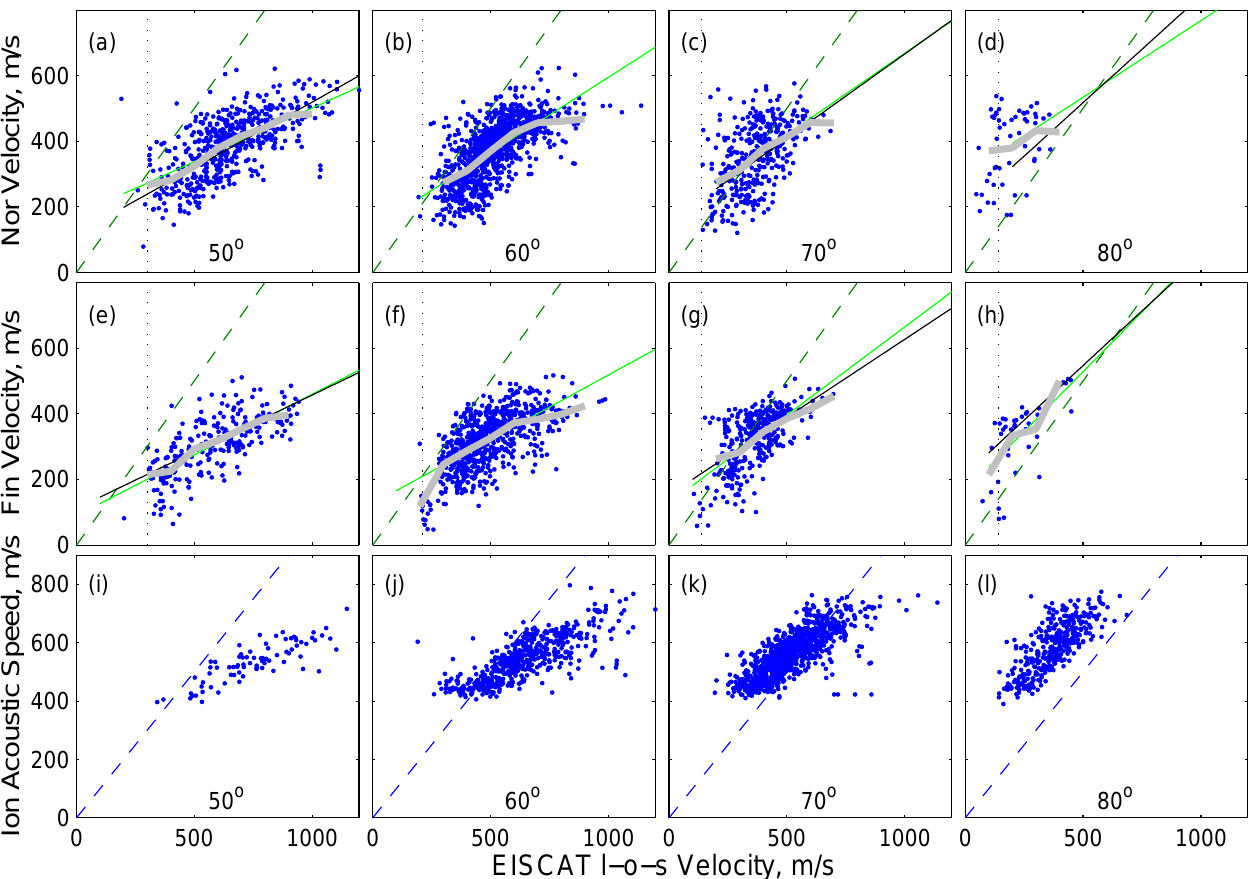
and V F , versus the EISCAT l-o-s irr irr > , over 100-m/s interval irr and irr